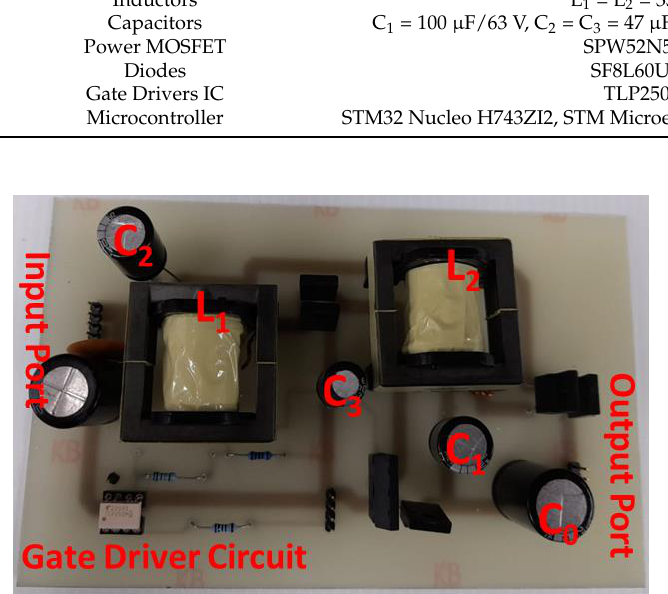
Figure 15. The proposed converter I hardware prototype.